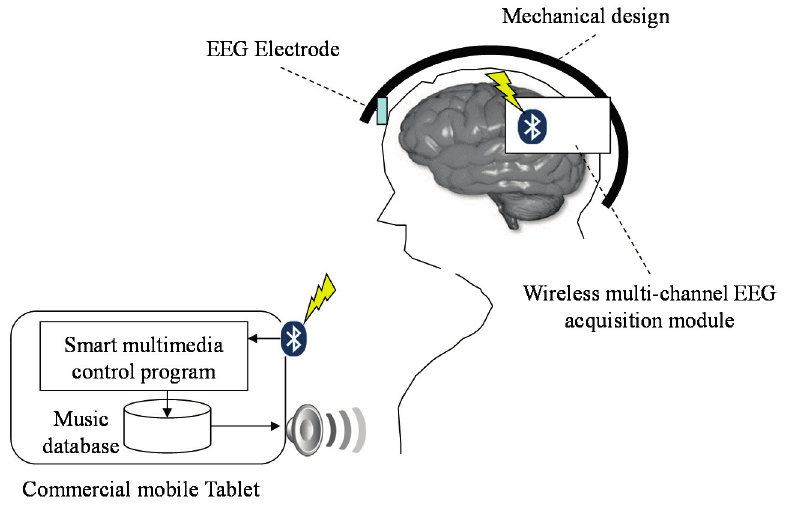
Figure 1. Basic scheme of proposed brain computer interface-based mobile multimedia